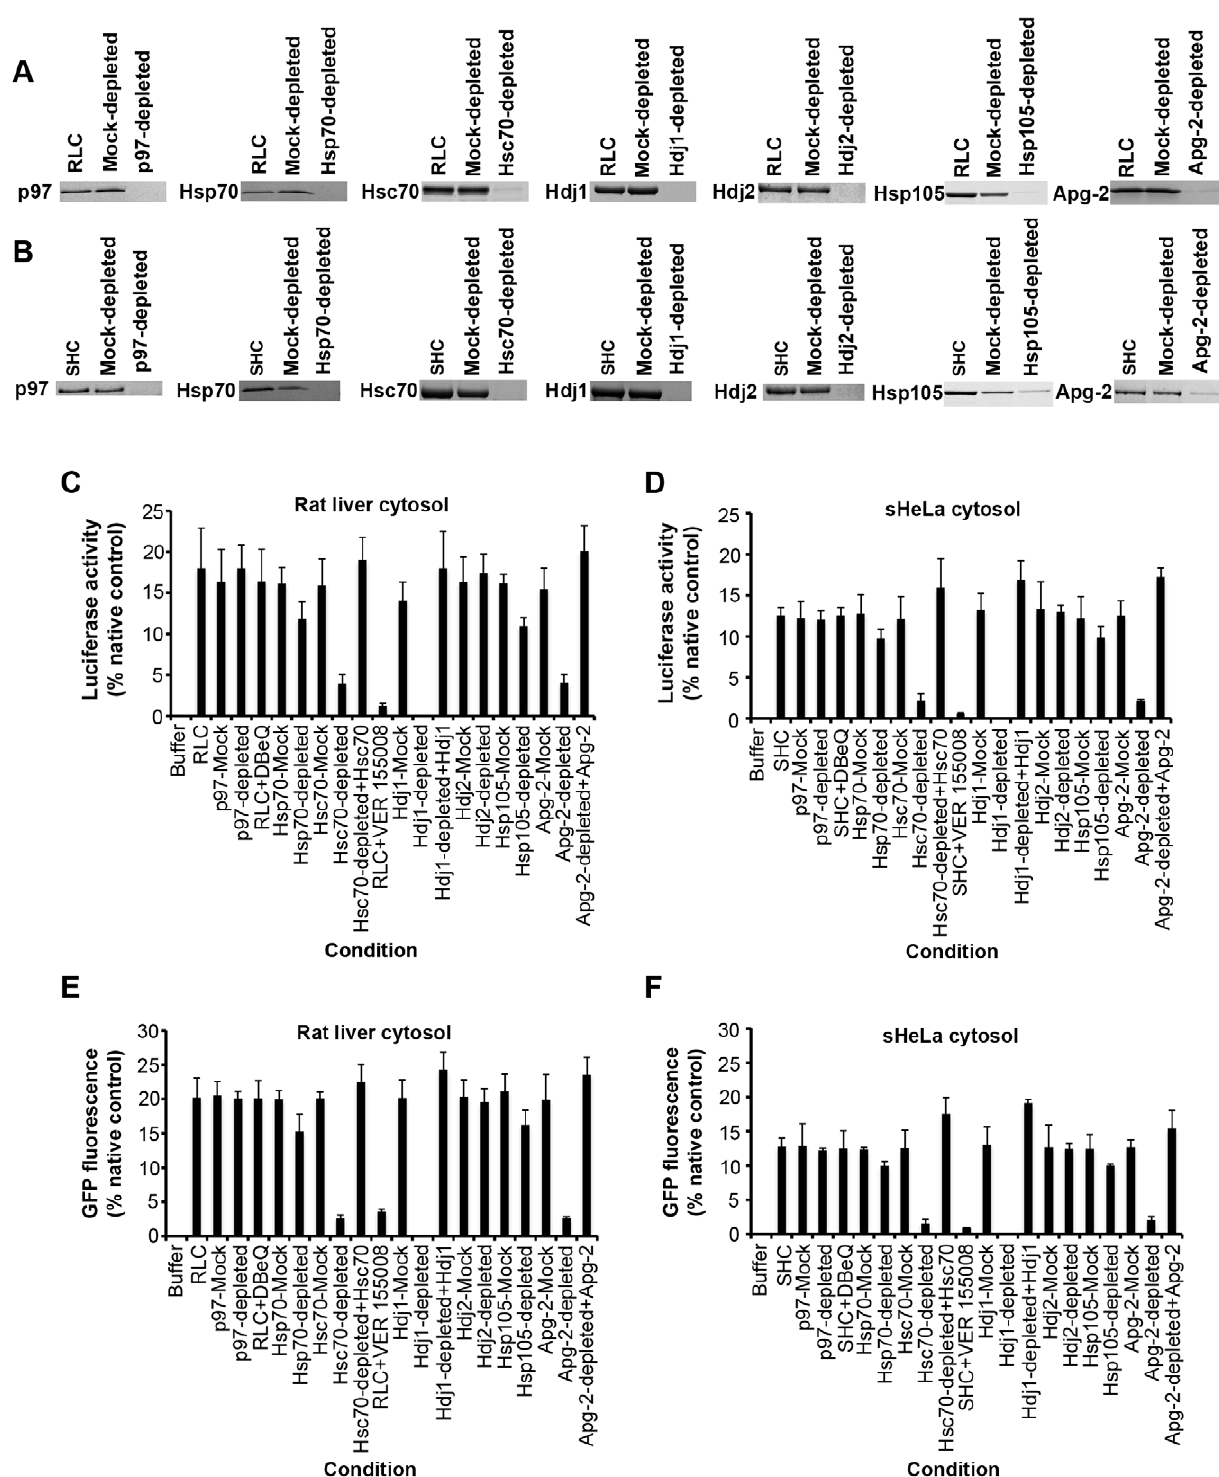
Figure 2. Hsp110, Hsp70 and Hsp40 are key components of the mammalian disaggregation machinery. ( A, B ) Immunoblots showing depletion of either p97, Hsp70, Hsc70, Hdj1, Hdj2, Hsp105 or Apg-2 from either RLC ( A ) or SHC ( B ) as described in Materials and Methods. 20 m g of cytosol was fractionated by SDS-PAGE and processed for immunoblot. ( C–F ) Urea-denatured luciferase aggregates (50 nM) ( C, D ) or heat-denatured GFP aggregates (0.45 m M) ( E, F ) were incubated for 6 h in buffer plus ATP (5 mM) and ATP-regeneration system without or with the indicated cytosol (10 mg/ml), mock-depleted cytosol (10 mg/ml) or depleted cytosol (10 mg/ml). In the indicated reactions, the small molecule p97 inhibitor, DBeQ (100 m M), or Hsp70 inhibitor, VER 155008 (100 m M), were included. In the indicated reactions, Hsc70-depleted cytosol was supplemented with Hsc70, Hdj1-depleted cytosol was supplemented with Hdj1 and Apg-2-depleted cytosol was supplemented with Apg-2 as described in Materials and Methods. Disaggregation and reactivation of luciferase was monitored by luminescence. Luminescence measurements were converted into